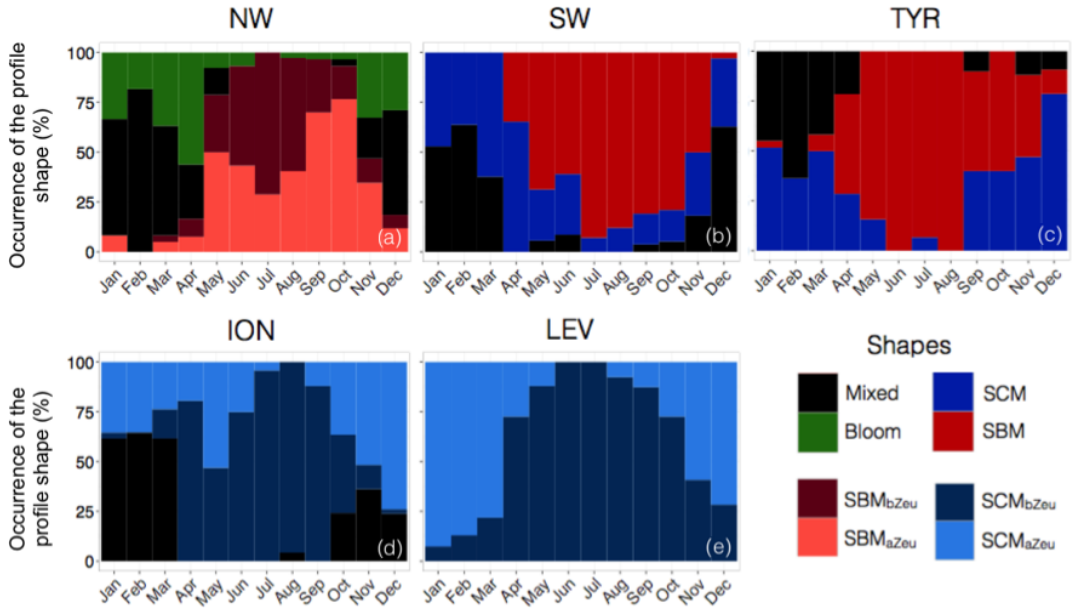
Figure 8. Monthly occurrence of the different types of profile shape for each of the five considered Mediterranean regions. The colour code indicates the type of profile shape, namely bloom, mixed, SBM (subsurface biomass maximum) with a distinction between the SBM aZ eu and the SBM bZ eu (for SBM occurring above or below the euphotic depth), and the SCM (subsurface chlorophyll maximum) with a distinction between the SCM aZ eu and the SCM bZ eu (for SCM occurring above or below the euphotic